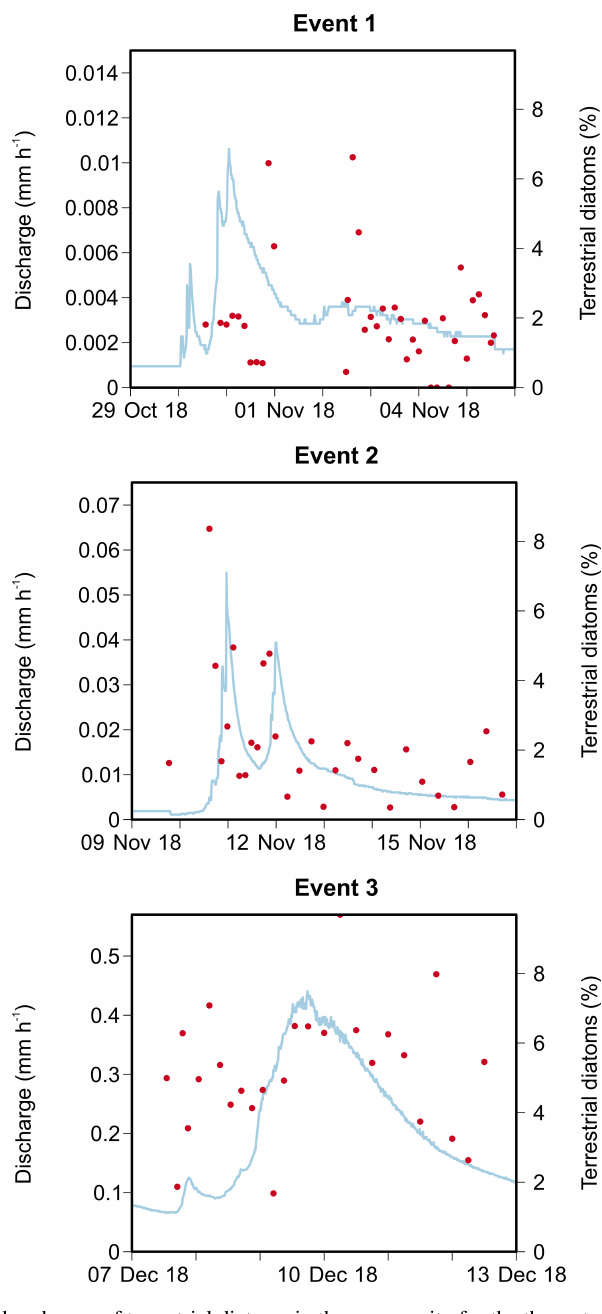
Figure A1. Discharge and relative abundances of terrestrial diatoms in the community for the three storm run-off